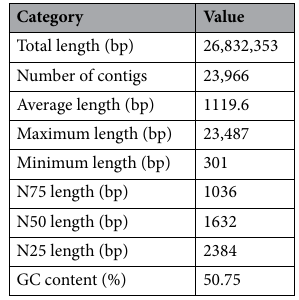
Table 1. Summary of genome-guided Trinity transcriptome assembly results.